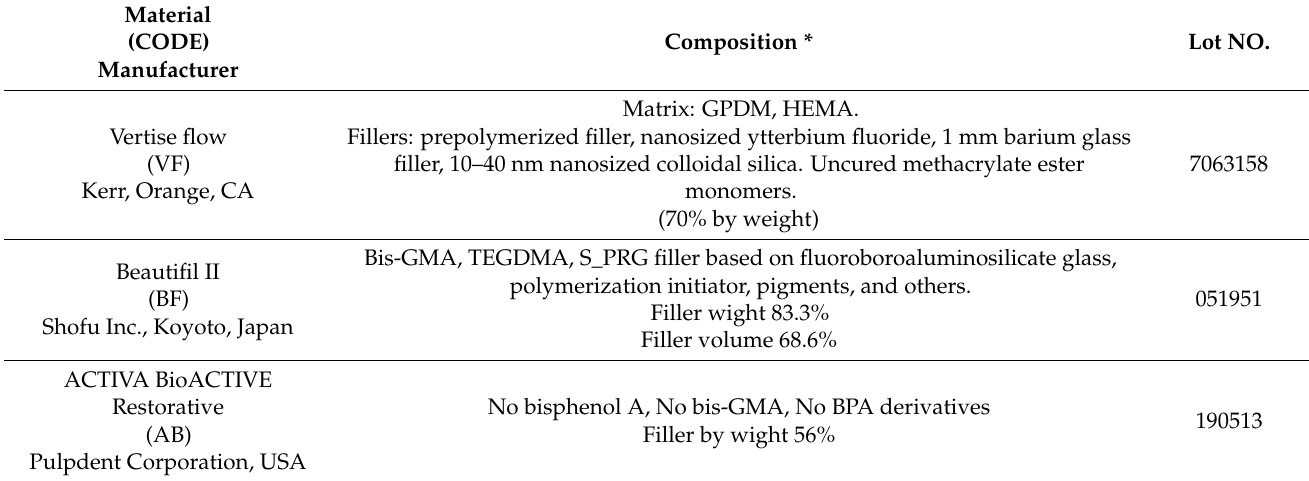
Table 1. The chemical composition of the used materials in the